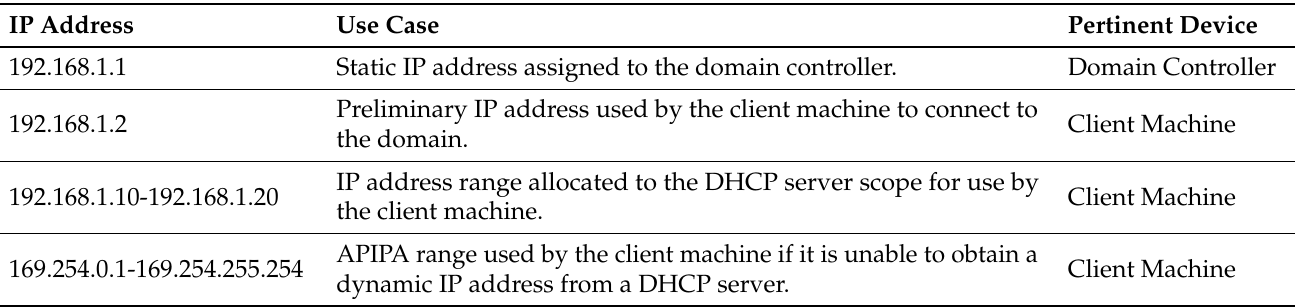
Table 1. Network configuration of the devices.